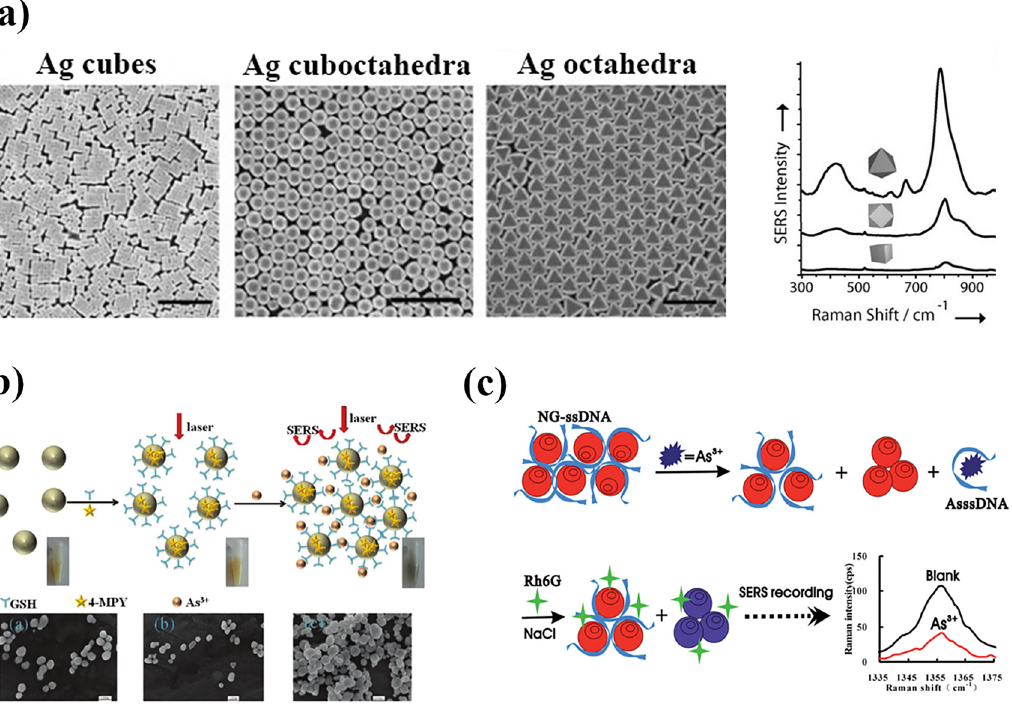
Figure 5: Representative strategies for efficient detection of As(III) or As(V). (a)Directdetectionofarsenateandarsenitebasedonthecharacteristicpeaksat800and425cm − 1 [91].(b)Aggregationinducedbycombining with GSH [96]. (c) As 3 + ions are speci fi cally complexed with aptamer